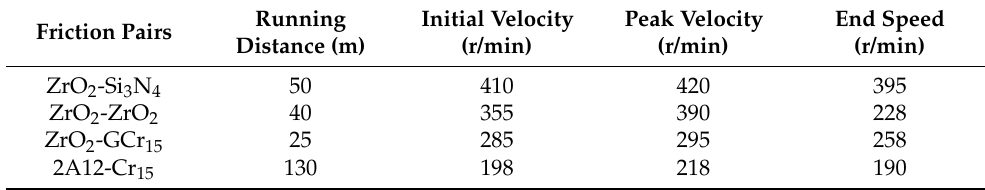
Table 2. Variation in the output speed of different friction pairs.